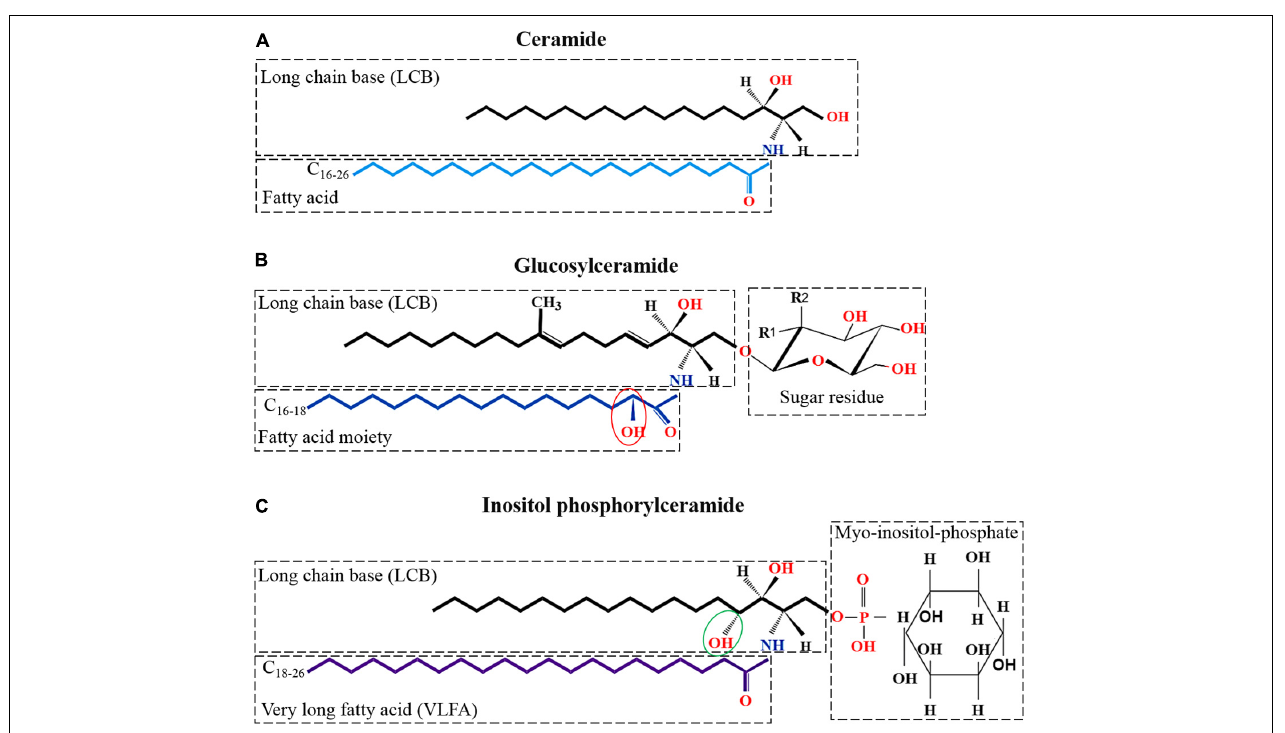
FIGURE 1 | Kinds and structures of glycosphingolipid in filamentous fungi. (A) Structure of ceramide; the basic unit of neutral and acidic glycosphingolipids; made up of a LCBs and a FA moiety. (B) Structure of neutral glycosphingolipid which is linked to a sugar residue on the base of ceramide. Neutral glycosphingolipid contains an-OH moiety at C 2 in the FA chain (showed with red ellipse); a double bond between C 4 - 5 and C 8 - 9 ; and a methyl C 9 of the LCB. Monosaccharide may be either glucosyl (Glc) (R1 = OH, R2 = H) or galactosyl (Gal) residues (R1 = H, R2 = OH). (C) The basic structure of acidic glycosphingolipid, inositol phosphorylceramide, is shown. Inositol phosphorylceramide is different from neutral glycosphingolipids in that it contains an additional hydroxy at C 4 of the LCB (showed with green ellipse) and lacks double bonds between C 4 - 5 and C 8 - 9 , and the C 9 methyl of the LCB. In addition, acidic glycosphingolipids are composed of a very long FA chain (C 18 - 26 ) instead of the C 16 - 18 chain that found in neutral glycosphingolipids.